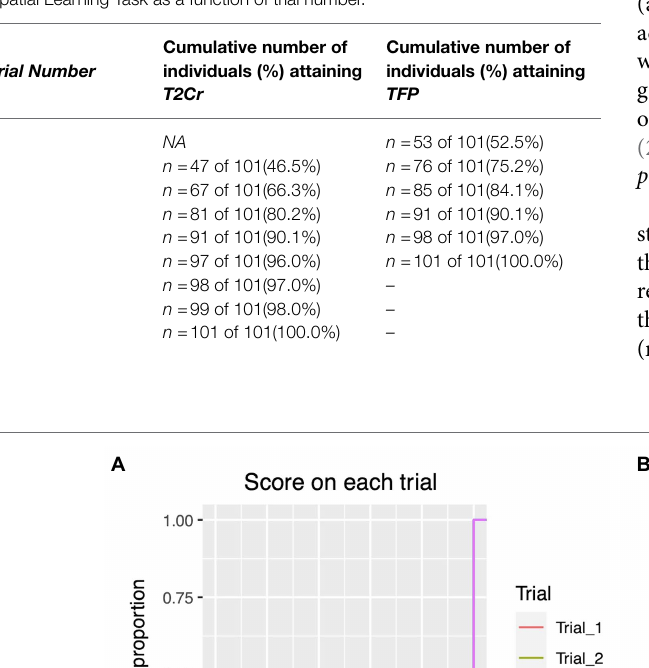
TABLE 3 | Cumulative number of participants attaining T2Cr and TFP on the Spatial Learning Task as a function of trial number.